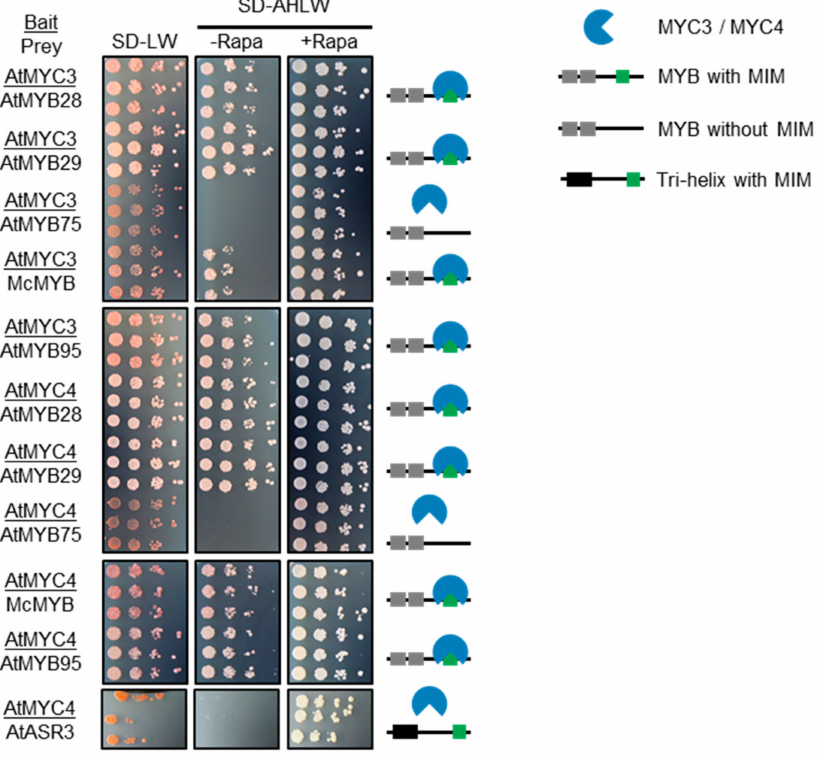
Figure 3. Testing interaction between A. thaliana (At) MYC3 and MYC4 against AtMYB28, AtMYB29, AtMYB75, AtMYB95, the MIM-containing trihelix MYB-like TF from A. thaliana (AtASR3), and MIM- containing R2R3 MYB TF from Macleaya cordata (McMYB). Growth on SD-LW medium confirms successful co-transformation with bait and prey construct and growth on SD-AHLW + Rapa medium indicates that bait and prey proteins are expressed and present in the same cellular compartment. The SD- AHLW-Rapa medium is selective for physical interaction of bait and prey protein. Rapa, rapamycin. For physiological relevance, MIM-containing proteins must encounter interaction partners in vivo. As the molecular constituents of JA signaling, including MYC2 homologs, are conserved in land plants [36,37], the species where we identified putative MIMs should also contain MYC TFs. Therefore, to extend our analysis to a physiologically relevant MYC TF, we performed a BLAST search using AtMYC2, AtMYC3 or AtMYC4 protein sequence as query against M. cordata protein sequences. All three queries result in the same top candidate: (UniProt ID) A0A200PXR5 (>50% sequence identity to each AtMYC